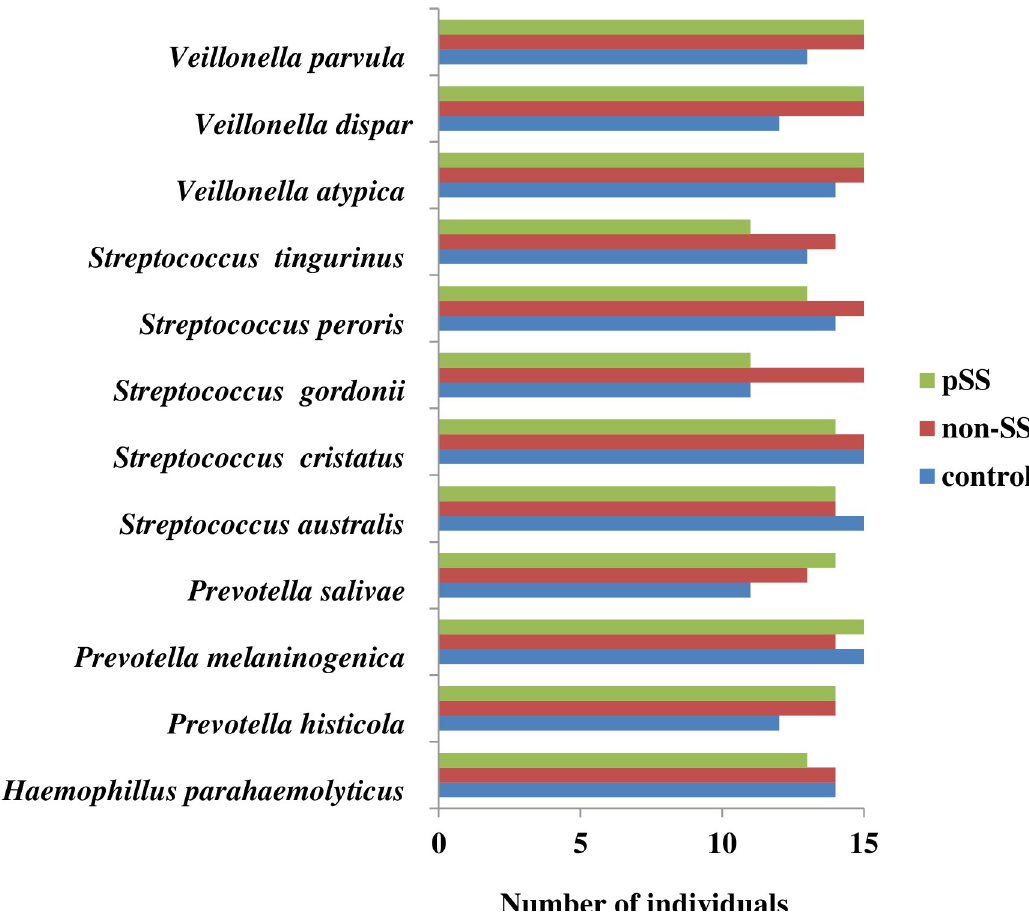
Fig 3. Predominant bacterial species detected in the three salivary sample